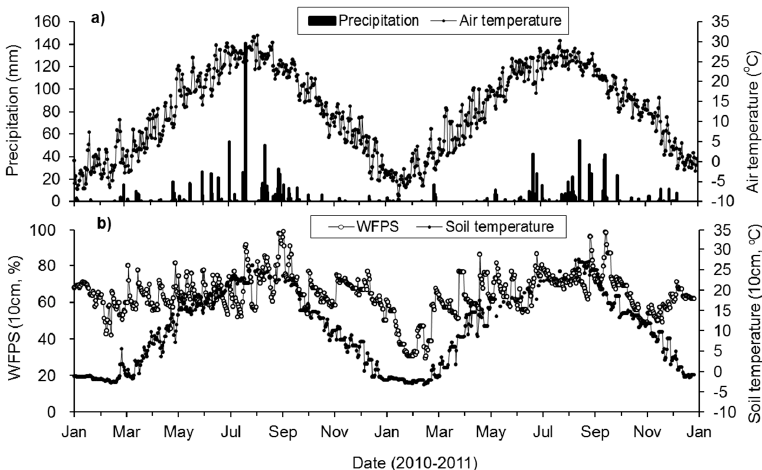
Figure 1. Seasonal dynamics between ( a ) air temperature ( ◦ C) and precipitation (mm); and ( b ) soil temperature (10 cm depth, ◦ C) and water-filled pore space (WFPS; 10 cm depth, %) in the studied apple orchard during 2010–2011.